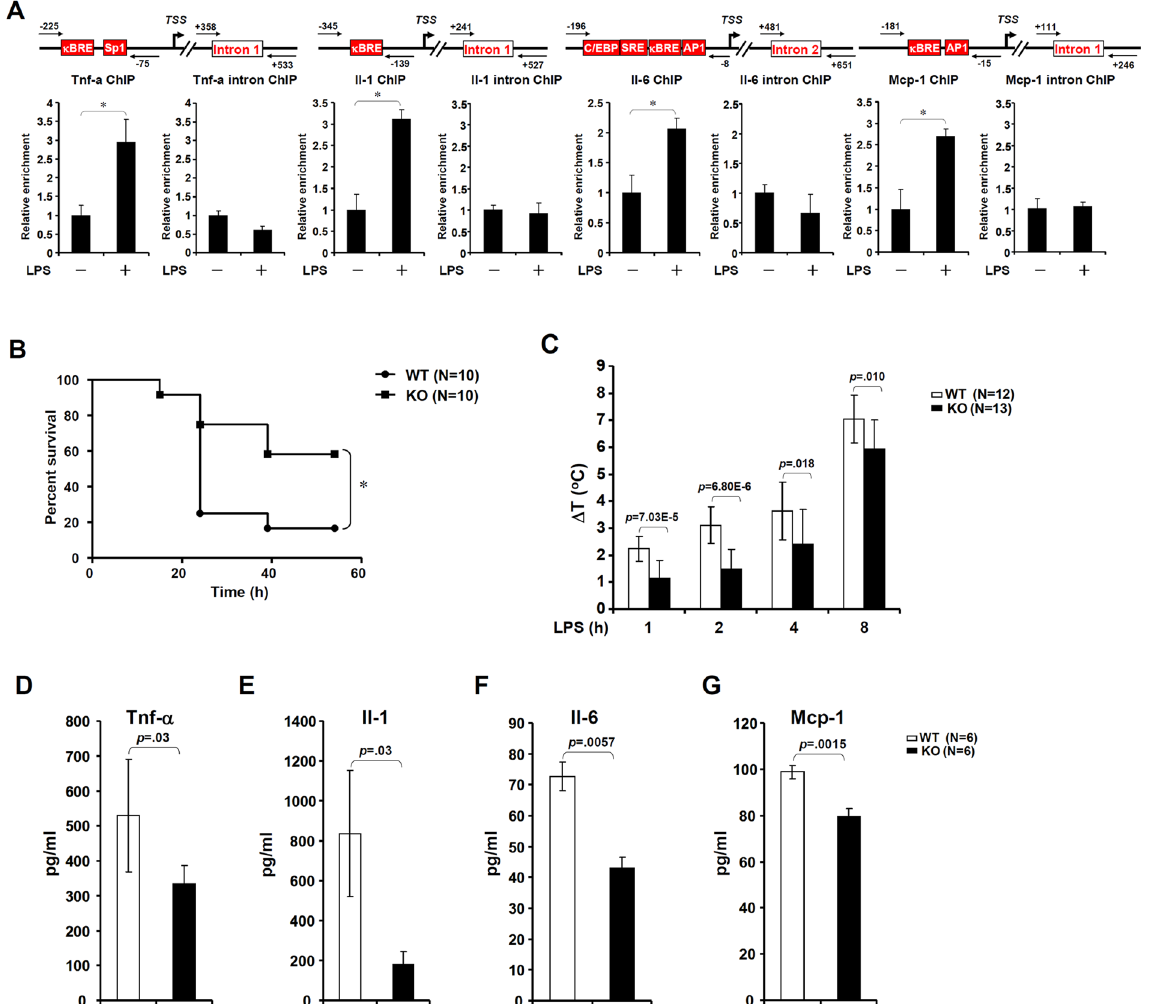
Figure 4. MKL1 deficiency cripples inflammatory response in mice. ( A ) C57/BL6 mice were injected with LPS (25 mg/kg). Peritoneal macrophages were isolated 6 hours after injection and ChIP assays were performed with anti-MKL1. ( B , C ) Sex- and age-matched WT and MKL1 KO male mice were injected with LPS (25 mg/kg). Survival ( B ) and body temperature ( C ) were monitored following injection. N = 10 mice for each group. ( D – G